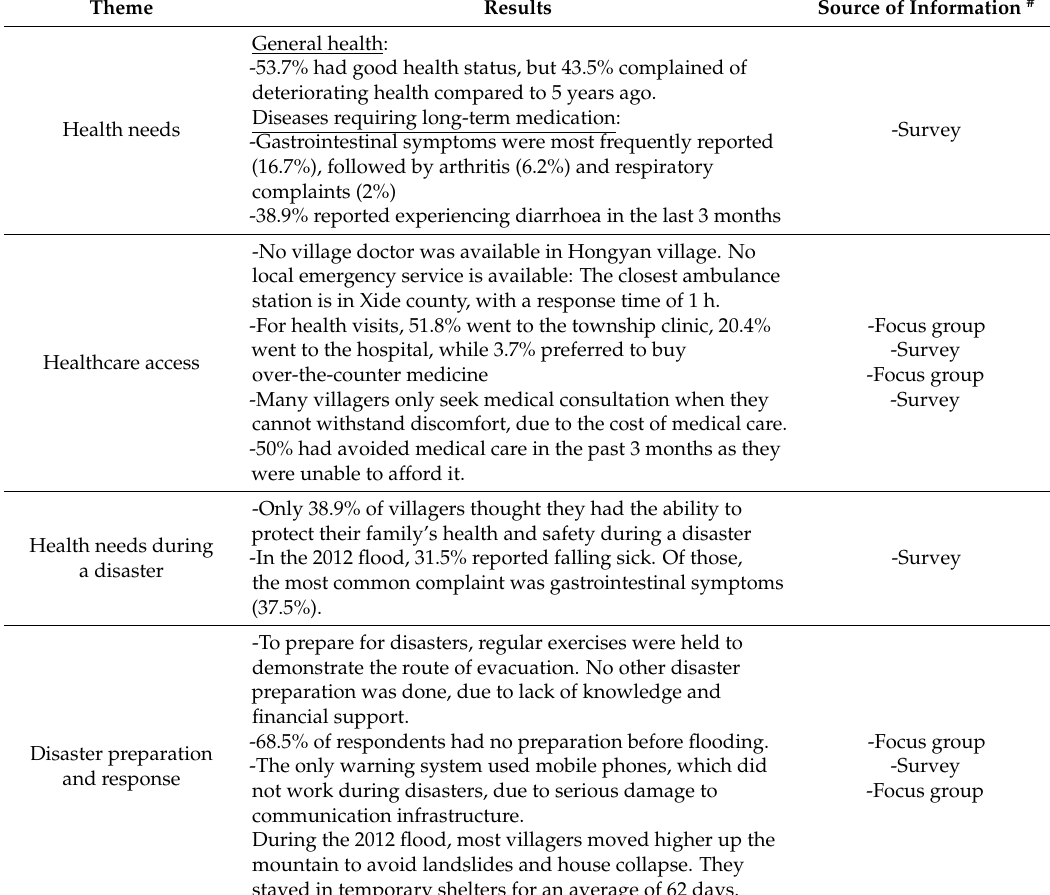
Table 3. The community needs and perceived priorities in Hongyan